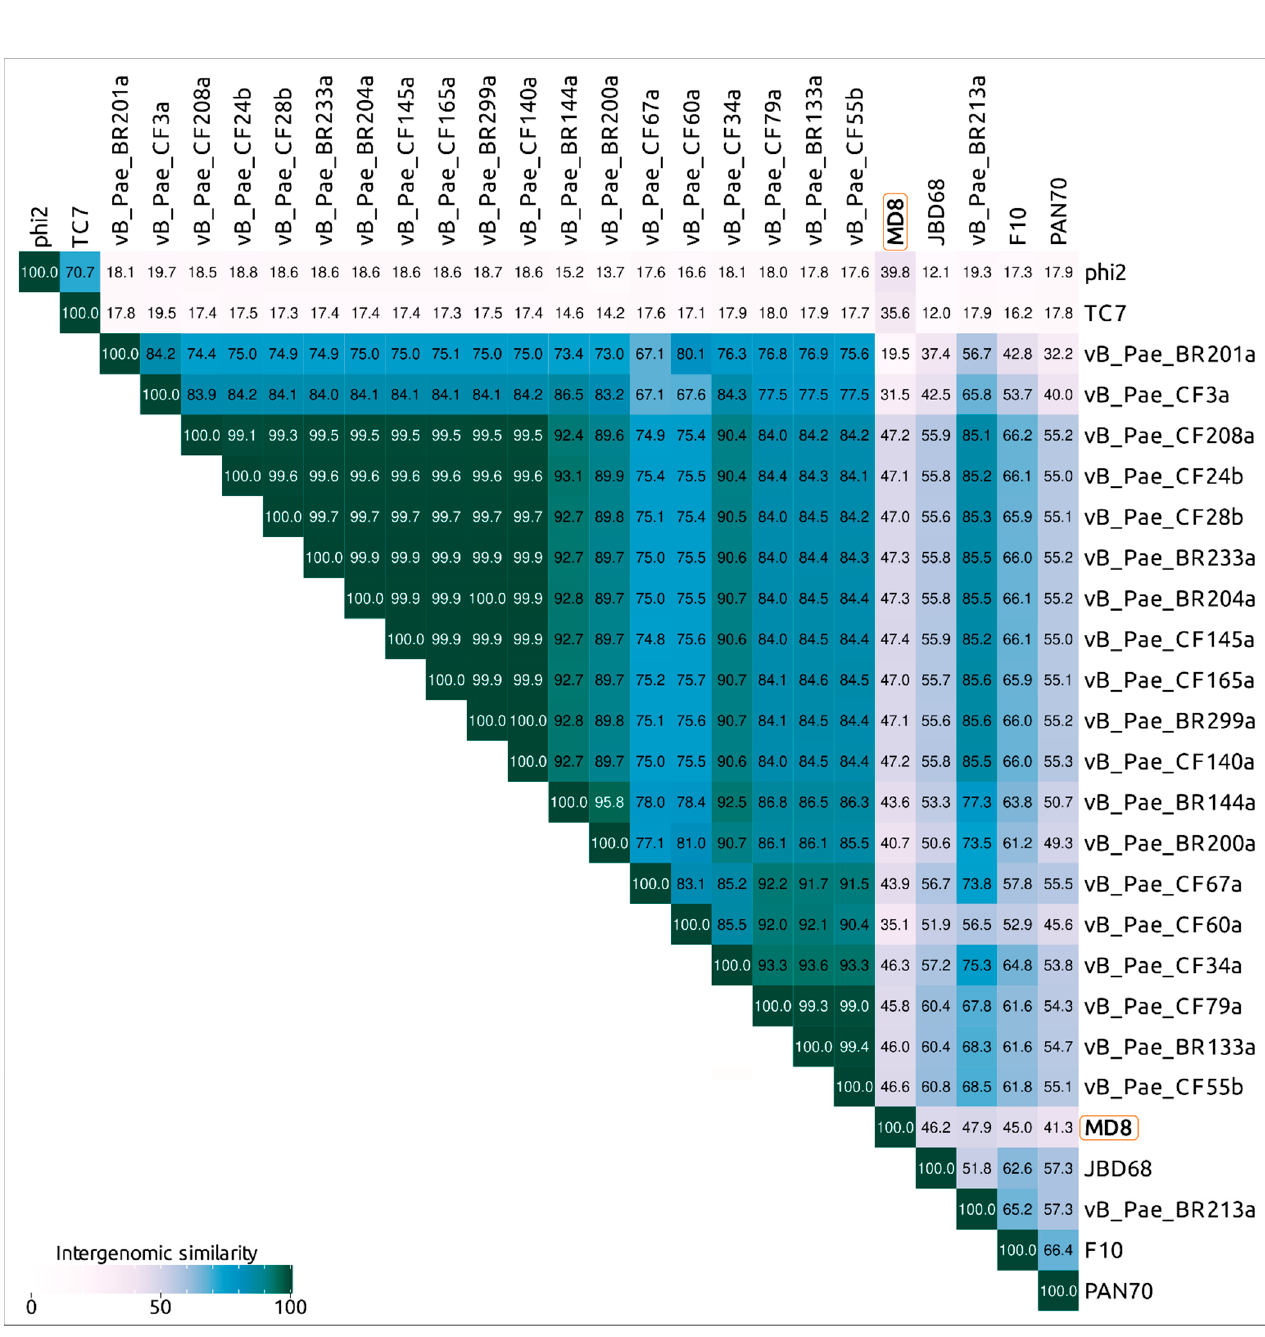
Figure 4. VIRIDIC generated heatmap of 26 “MD8-like” Pseudomonas phages. The colour coding indicates the clustering of the phage genomes based on intergenomic similarity. The numbers represent the similarity values for each genome pair, rounded to the first decimal.